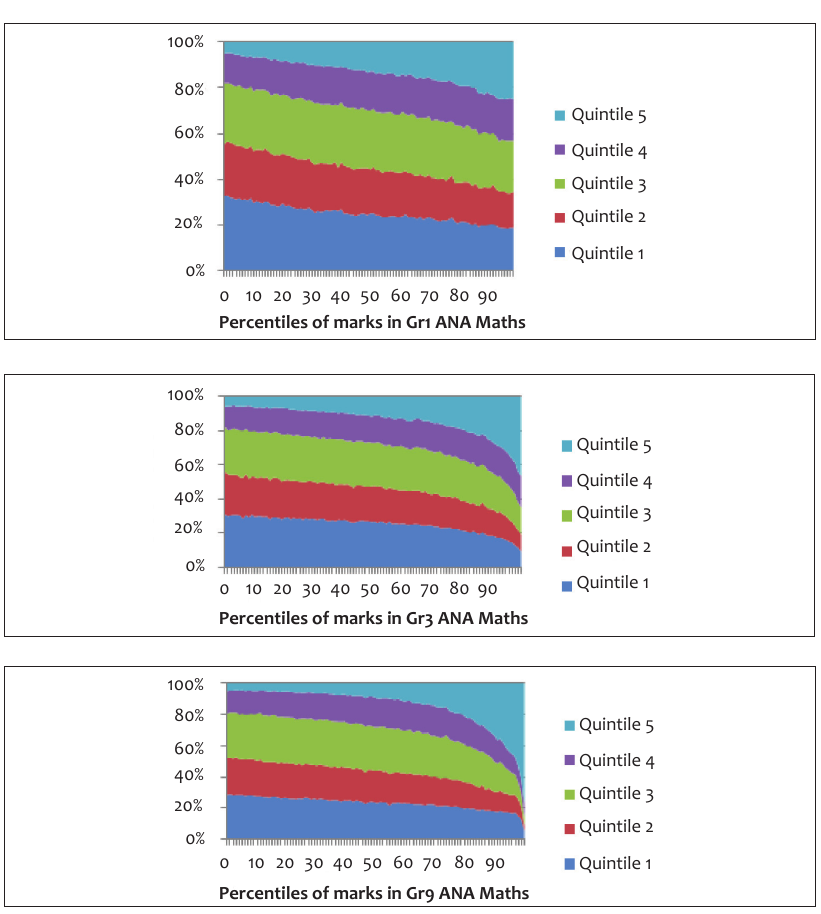
Figure 1: Quintile distribution across percentiles of 2012 ANA performance in Grades 1, 3 & 9 (Source: Own calculations from ANA